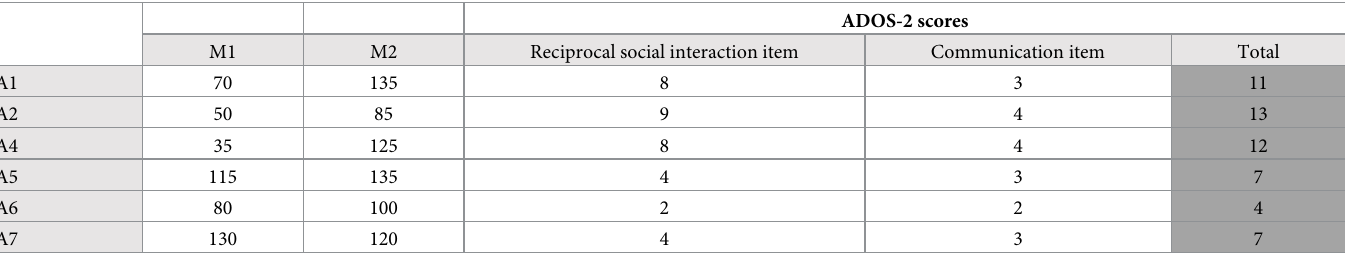
Table 3. Comparisons between M1 and M2 levels and ADOS scores in ASD individuals (N =